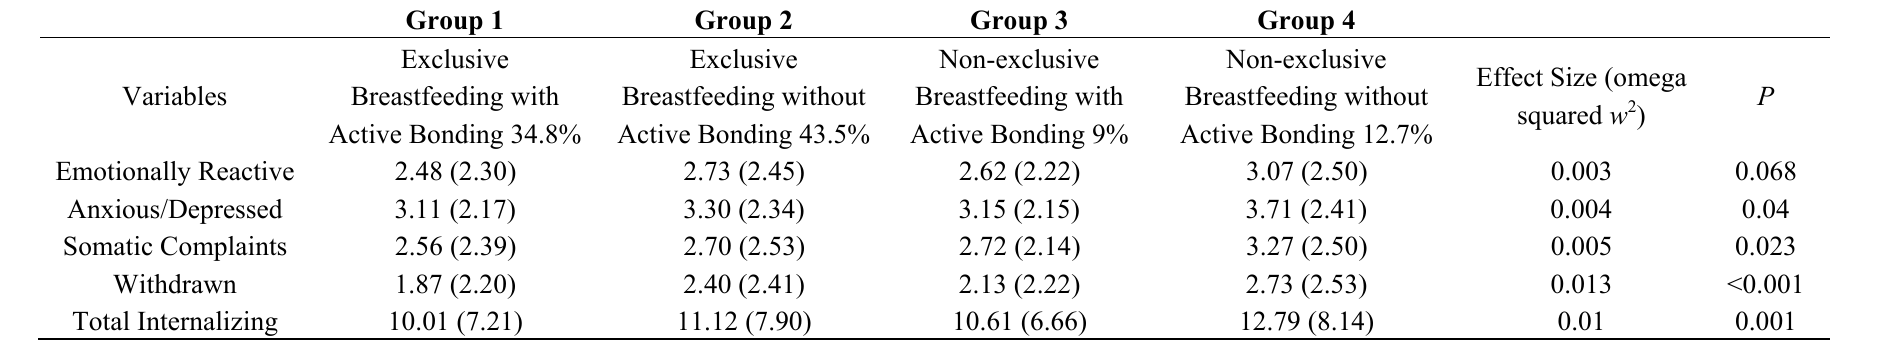
Table 2. Combined Effect of Breastfeeding and Active Bonding on Behavior Problems from